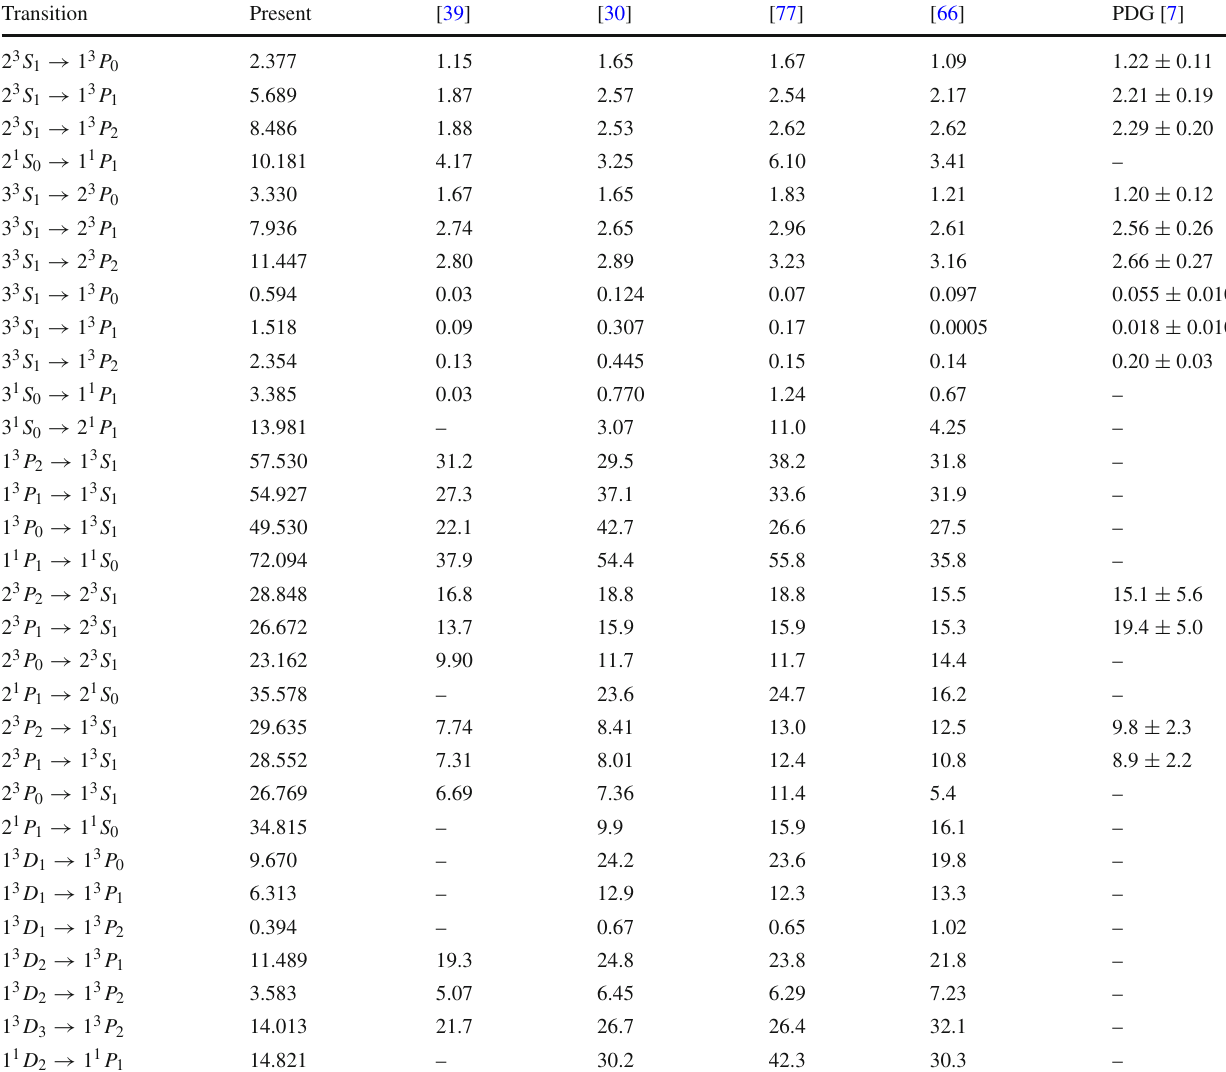
Table 21 E 1 transition width of bottomonia (in keV)